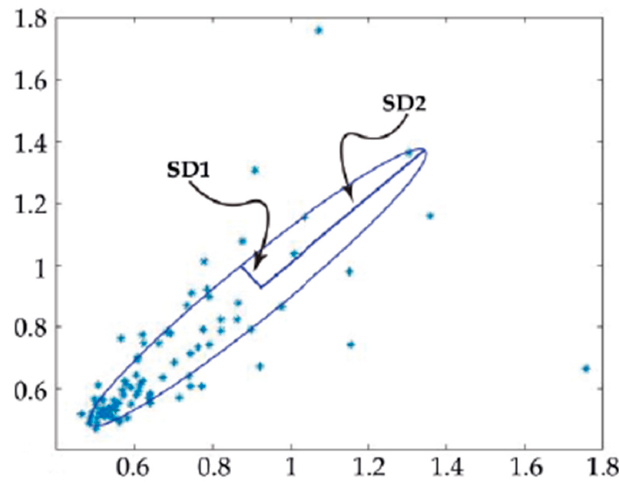
Figure 6. Example of a Poincaré plot obtained using the beating recording of the control cardiomy- ocytes in Figure 5.